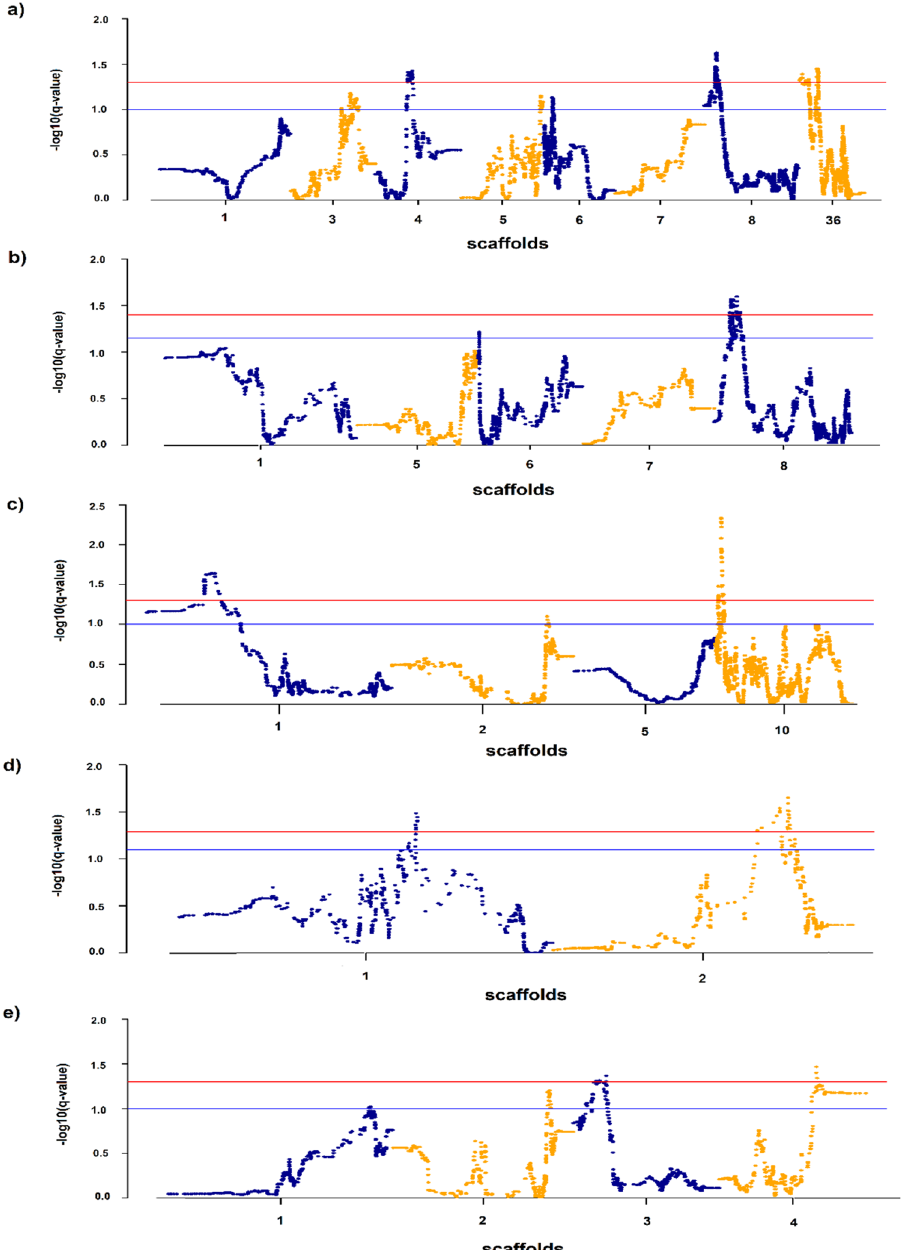
Figure 3. Manhattan plots of hapFLK statistic in different groups: ( a ) kidney lesions ( b ) virus clearance ( c ) survival ( d ) antibody titer and ( e ) viremia-350. Blue and red lines indicate suggestive (q-value < 0.10) and significant (q-value < 0.05) thresholds,